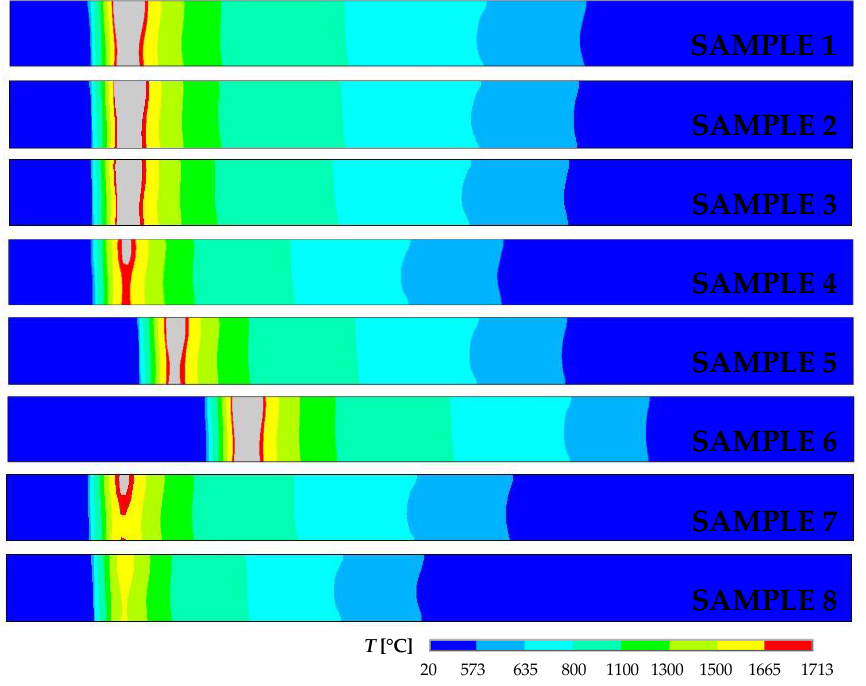
Figure 10. Details of computed temperature fields in the longitudinal sections along the weld centerline in a time of 1 s for samples from 1 to 8.